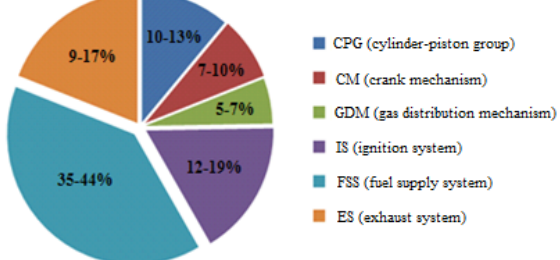
Figure 1. The statistics of car system failures